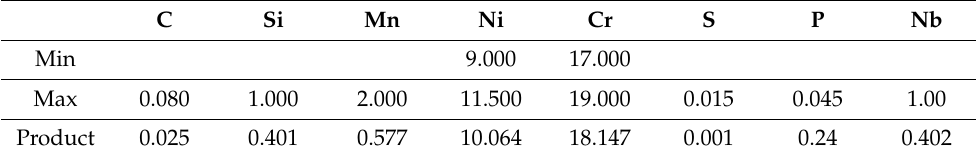
Table 1. Chemical composition of the AISI 347 (X6CrNiNb18-10). C Si